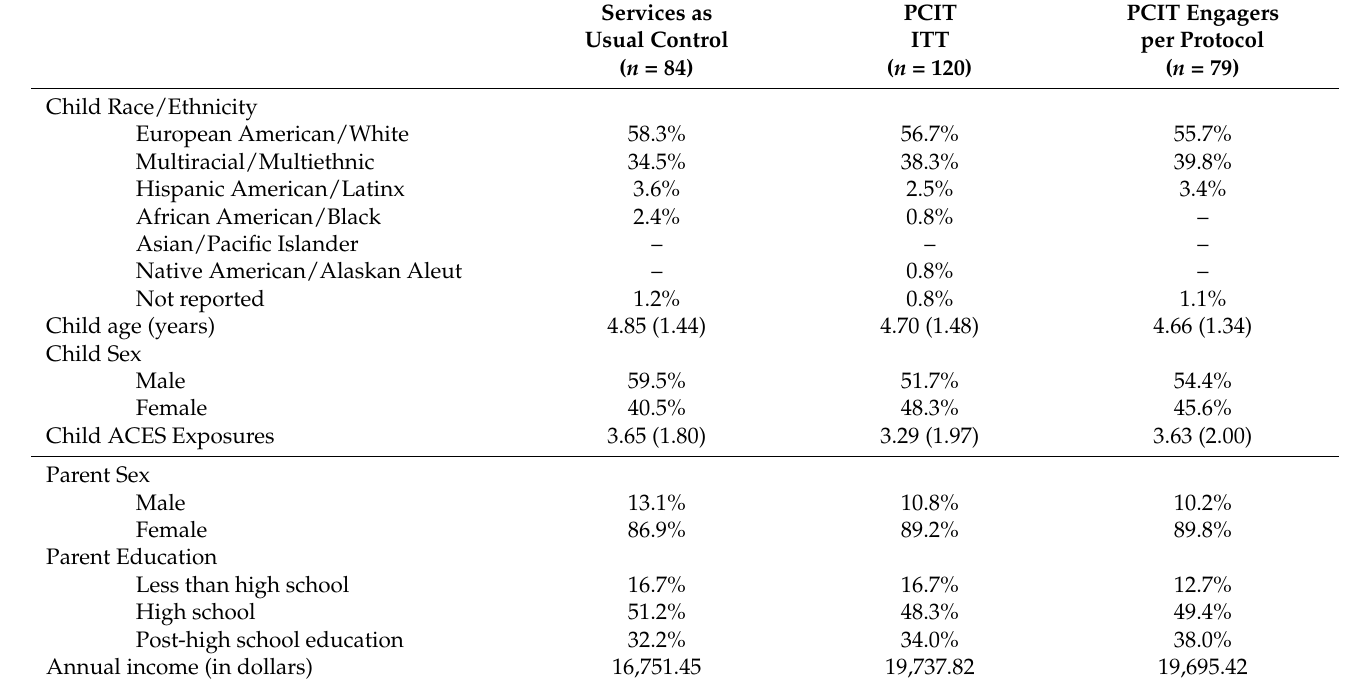
Table 1. Demographic characteristics of children by the treatment condition ( n =